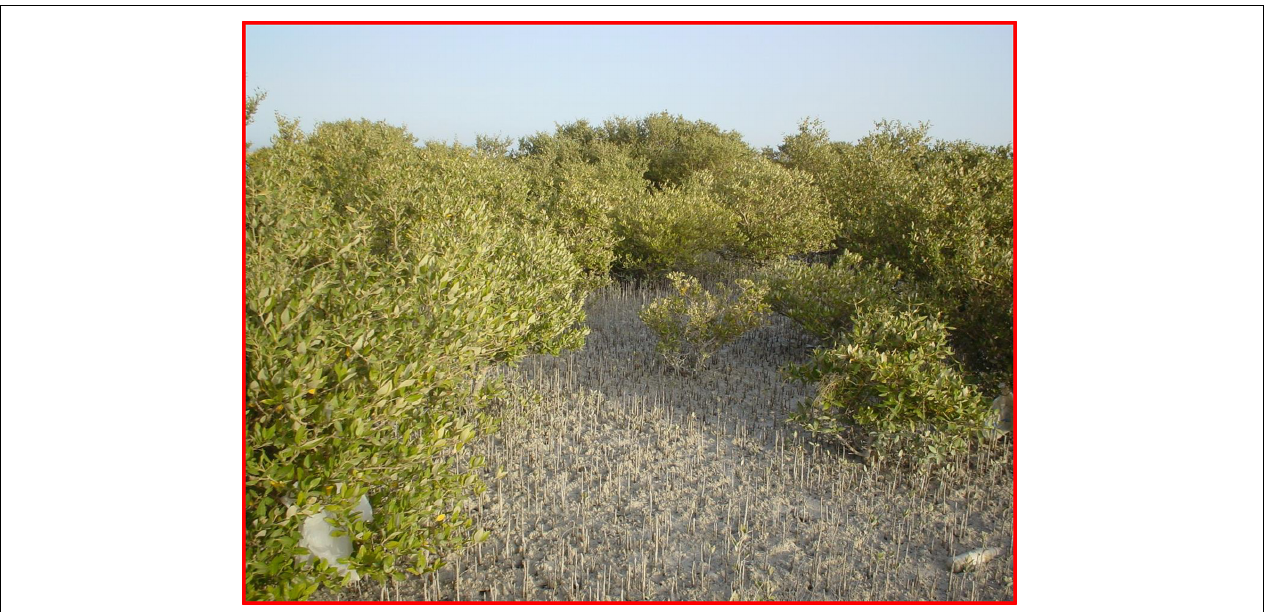
FIGURE 2 | Mangrove forests at the coastal lines of the State of